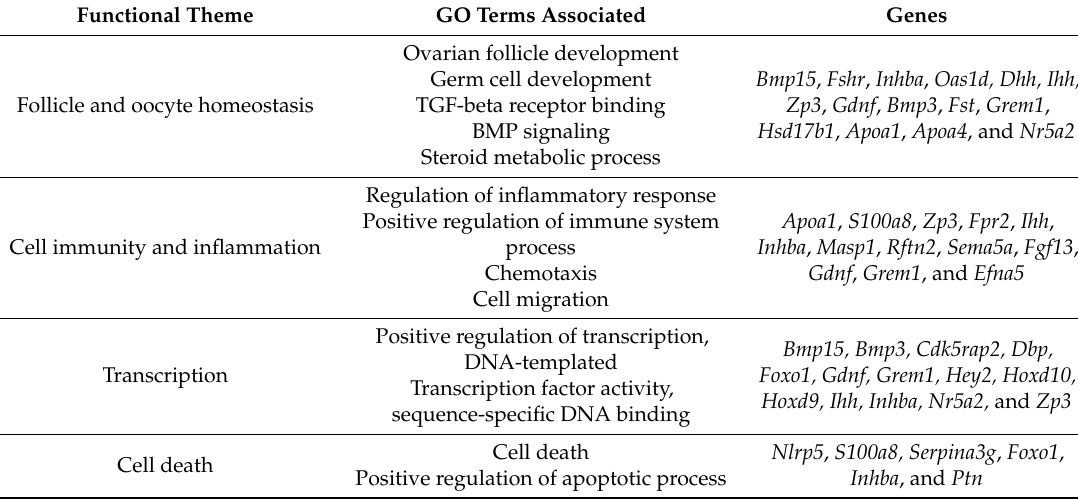
Figure 3. Gene ontology (GO) profile of di ff erentially expressed genes in aged ovaries. Analysis of DEGs between ( A ) aged versus young, and ( B ) aged virgin versus aged multiparous ovaries after limma tests, as described in Methods. The aged / young test resulted in a similar number of up- and down-regulated genes. As the aged virgin / aged multiparous comparison resulted in unbalanced up- and down-regulated gene numbers (65 versus 112), the GO enrichment was converted into percentages. The VLAD tool was run with o ffi cial M musculus gene symbols (adj p < 0.05; gene function annotation from Mammalian Genome Informatics (MGI)) with default parameters. Abbreviated GO terms: (*) “positive regulation of”; (#) “regulation of”. ( C ) GSEA analysis of the genes upregulated in multiparous ovary using the C5 (GO) collection. Column headings are (1) receptor regulator activity (11 genes), (2) cell–cell signaling (16 genes), (3) extracellular matrix (10 genes), (4) molecular function regulator (16 genes), (5) collagen containing extracellular matrix (9 genes), and (6) signaling receptor binding (15 genes). All the terms met an FDR q -value < 4.1 × 10 − 5 . Table 2. Enriched GO terms in genes of higher expression in aged multiparous ovaries a